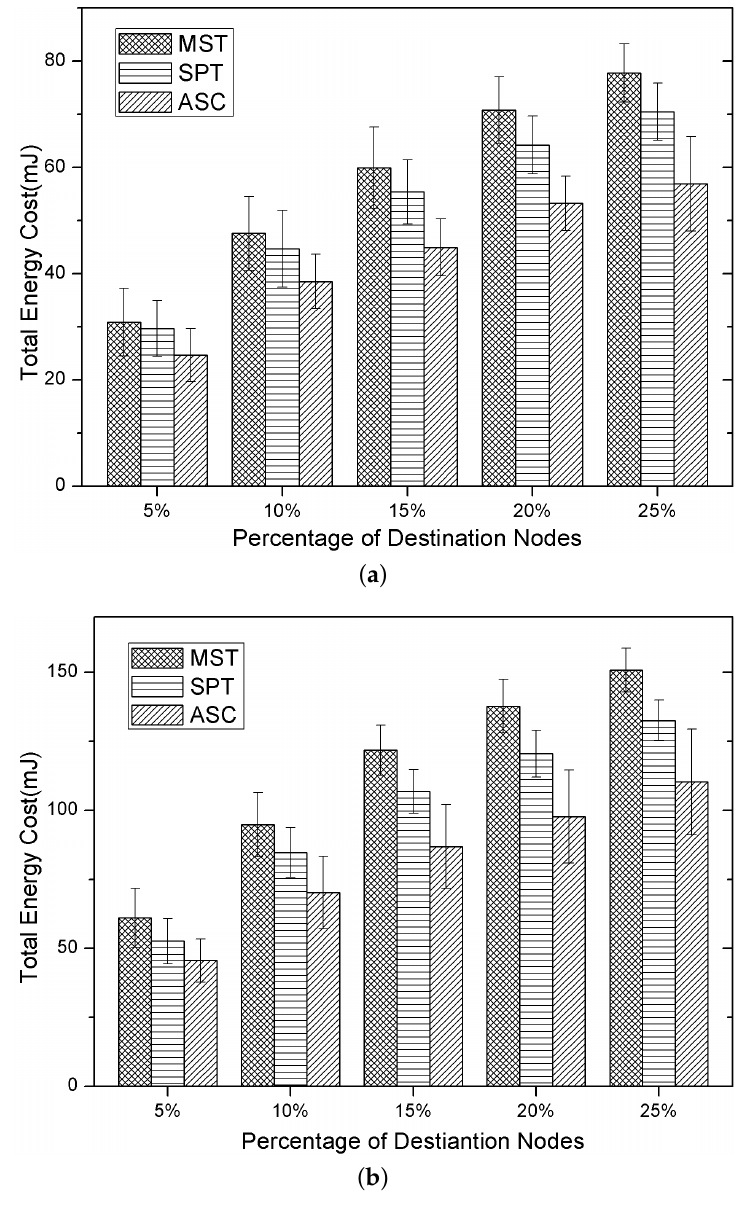
Figure 3. Total energy cost. ( a ) |V| = 100; ( b ) |V| =